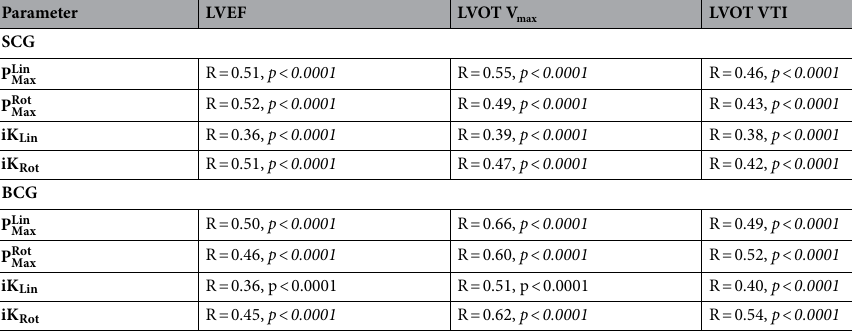
Table 5. Associations of P max and i K computed from SCG and BCG signals with hemodynamic parameters obtained with standard echocardiography. Spearman’s correlations between i K and P Max computed from the BCG and SCG in linear and rotational channels and LVEF, LVOT V max , LVOT VTI for all levels of dobutamine administration. SCG seismocardiography, BCG ballistocardiography, iK maximal kinetic energy, P Max maximal Power, LVEF left ventricle ejection fraction, LVOT V max left ventricle outflow tract maximal velocity, LVOTI VTI left ventricle outflow tract velocity time integral.